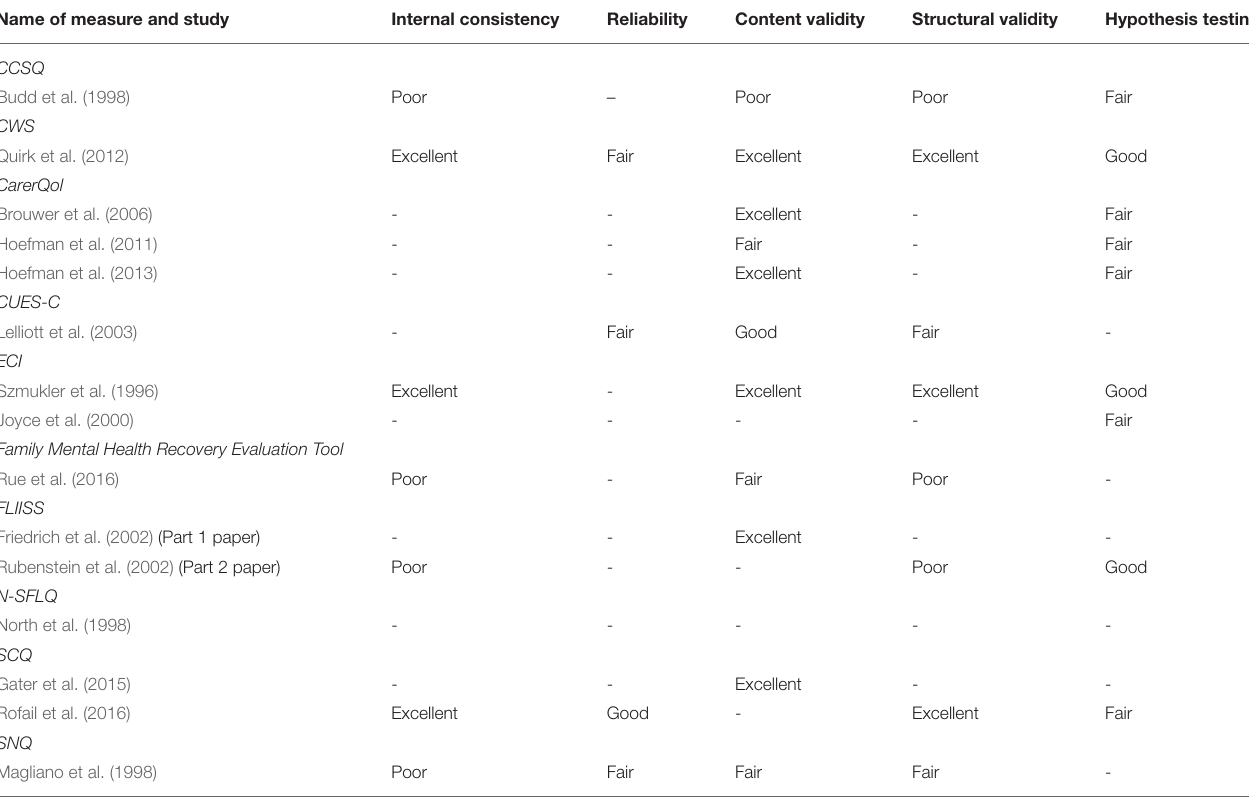
TABLE 3 | COSMIN results showing the methodological quality of each study per measurement property.